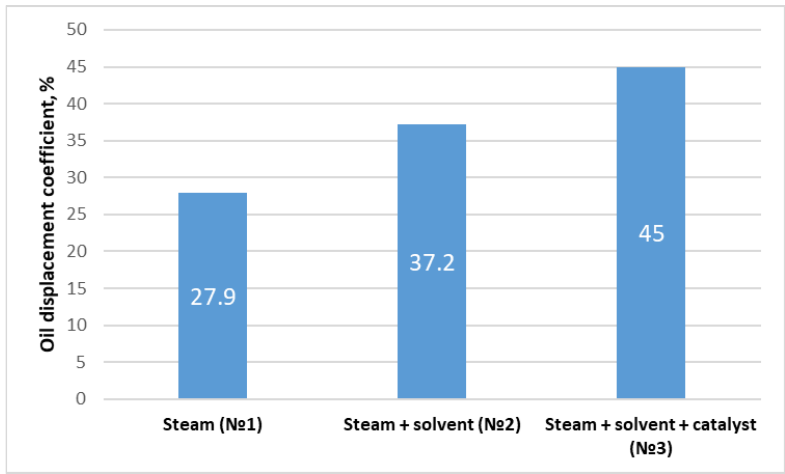
Figure 4. Distribution of oil displacement coefficients by experiments.